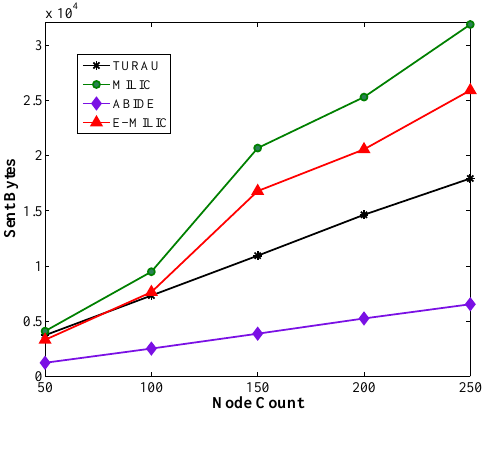
Figure 13. Comparisons between algorithms in terms of sent bytes. ( a ) Sent bytes against node count; ( b ) sent bytes against